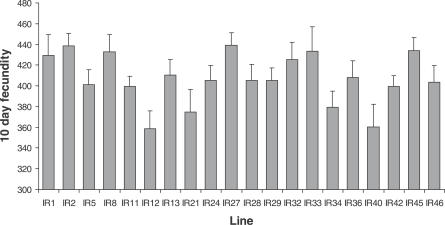
Effects of Wolbachia Strain on 10-d Fecundity of D. simulans Collected at Irvine in 2004 and Backcrossed for Two Generations to Males from Riverside Collected in 1988Error bars are standard errors.